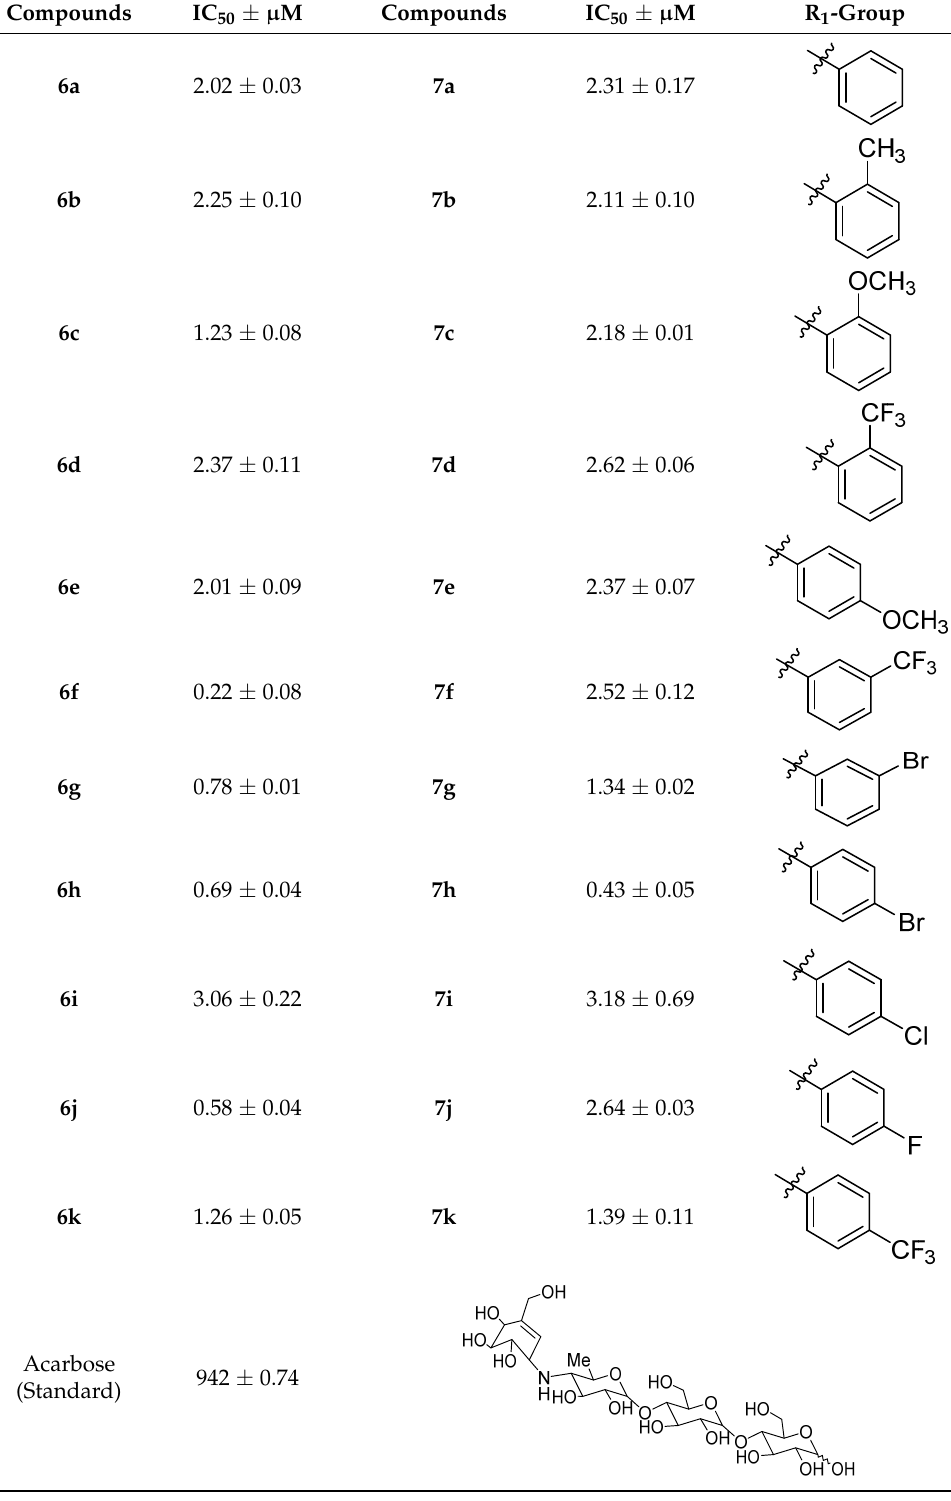
Table 2. In vitro α -glucosidase-inhibitory activities of compounds 6a–6k and 7a–7k . Table 2. In vitro α ‐ glucosidase ‐ inhibitory activities of compounds 6a–6k and 7a–7k . Table 2. In vitro α ‐ glucosidase ‐ inhibitory activities of compounds 6a–6k and 7a–7k . Table 2. In vitro α ‐ glucosidase ‐ inhibitory activities of compounds 6a–6k and 7a–7k . Table 2. In vitro α ‐ glucosidase ‐ inhibitory activities of compounds 6a–6k and 7a–7k . Table 2. In vitro α ‐ glucosidase ‐ inhibitory activities of compounds 6a–6k and 7a–7k . Table 2. In vitro α ‐ glucosidase ‐ inhibitory activities of compounds 6a–6k and 7a–7k . Table 2. In vitro α ‐ glucosidase ‐ inhibitory activities of compounds 6a–6k and 7a–7k . Table 2. In vitro α ‐ glucosidase ‐ inhibitory activities of compounds 6a–6k and 7a–7k . Table 2. In vitro α ‐ glucosidase ‐ inhibitory activities of compounds 6a–6k and 7a–7k . Table 2. In vitro α ‐ glucosidase ‐ inhibitory activities of compounds 6a–6k and 7a–7k . Table 2. In vitro α ‐ glucosidase ‐ inhibitory activities of compounds 6a–6k and 7a–7k . Compounds Table 2. In vitro α ‐ glucosidase ‐ inhibitory activities of compounds 6a–6k and 7a–7k . Compounds Compounds Compounds Compounds Compounds Compounds Compounds Compounds Compounds Compounds Compounds